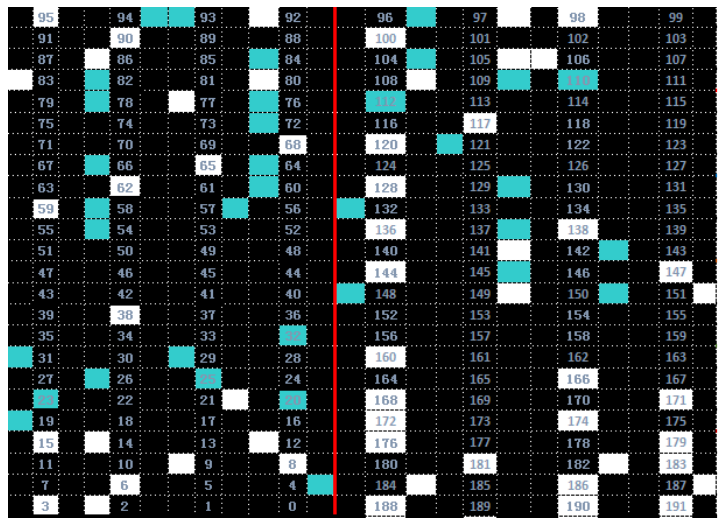
Figure 12. Numbering of processor bits.